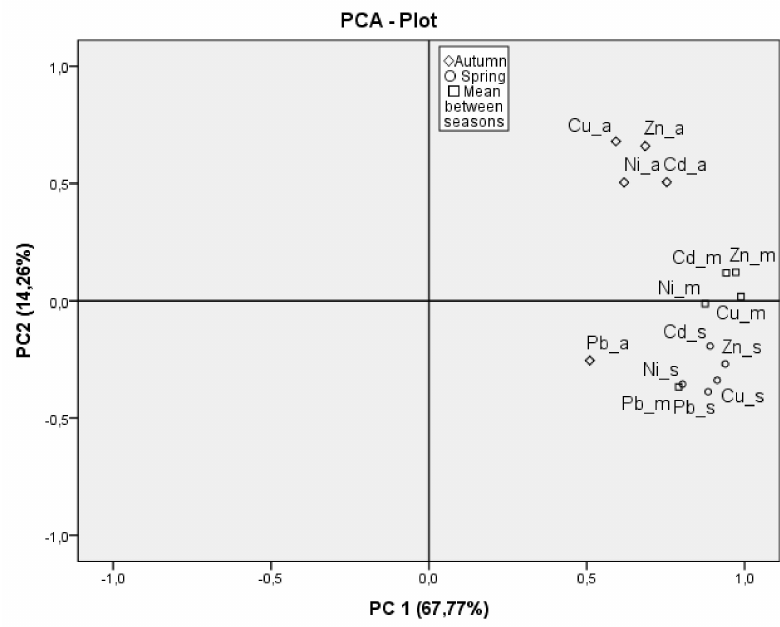
Figure 4. The PCA plot of seasonal variations in heavy metal concentrations.